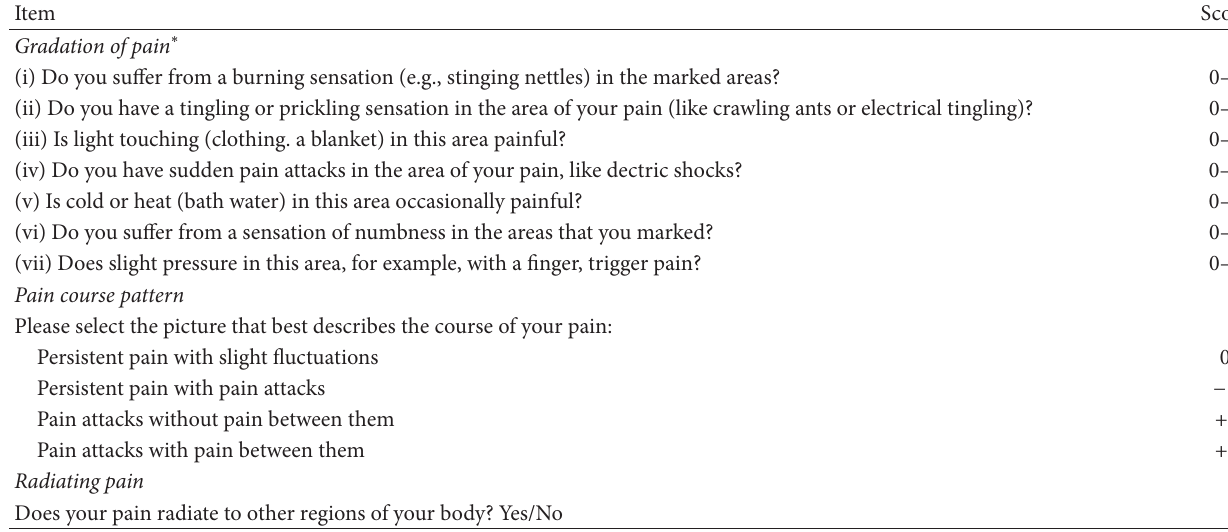
Table 1: Pain DETECT questionnaire [9].